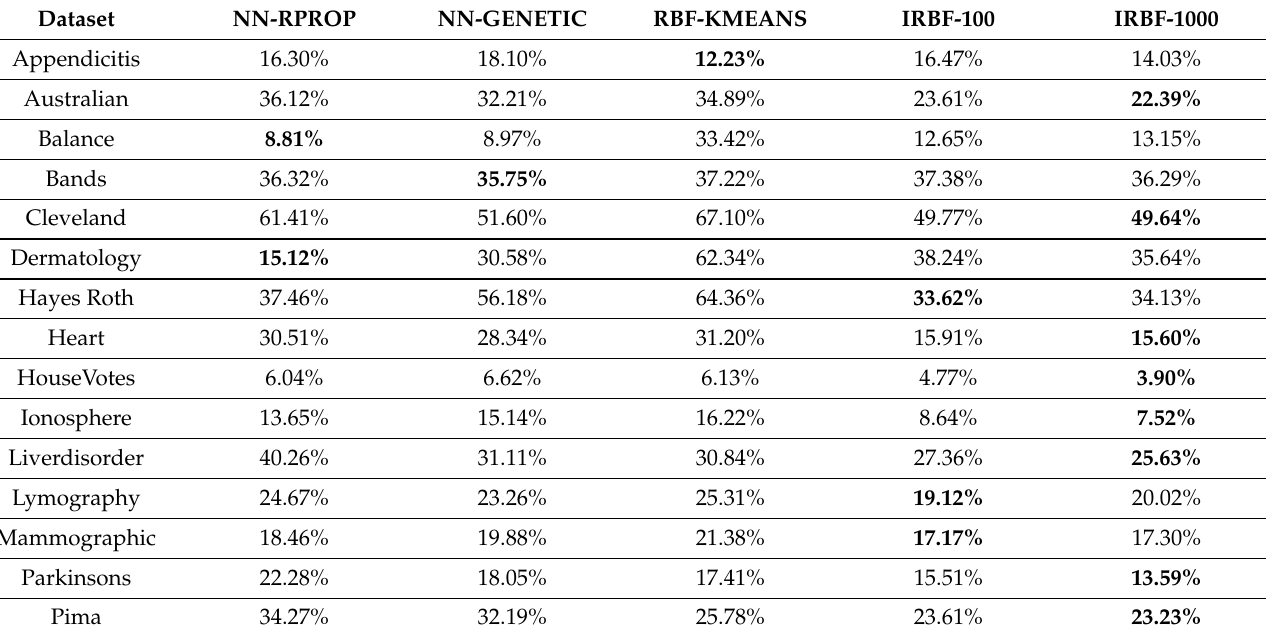
Table 2. Experimental results for the classification datasets. The first column is the name of the used